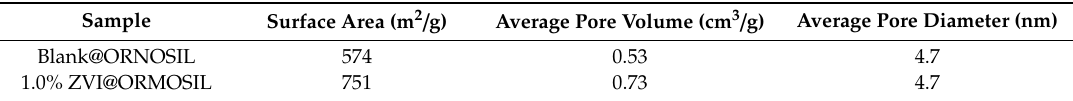
Table 3. N 2 adsorption-desorption isotherms summary.